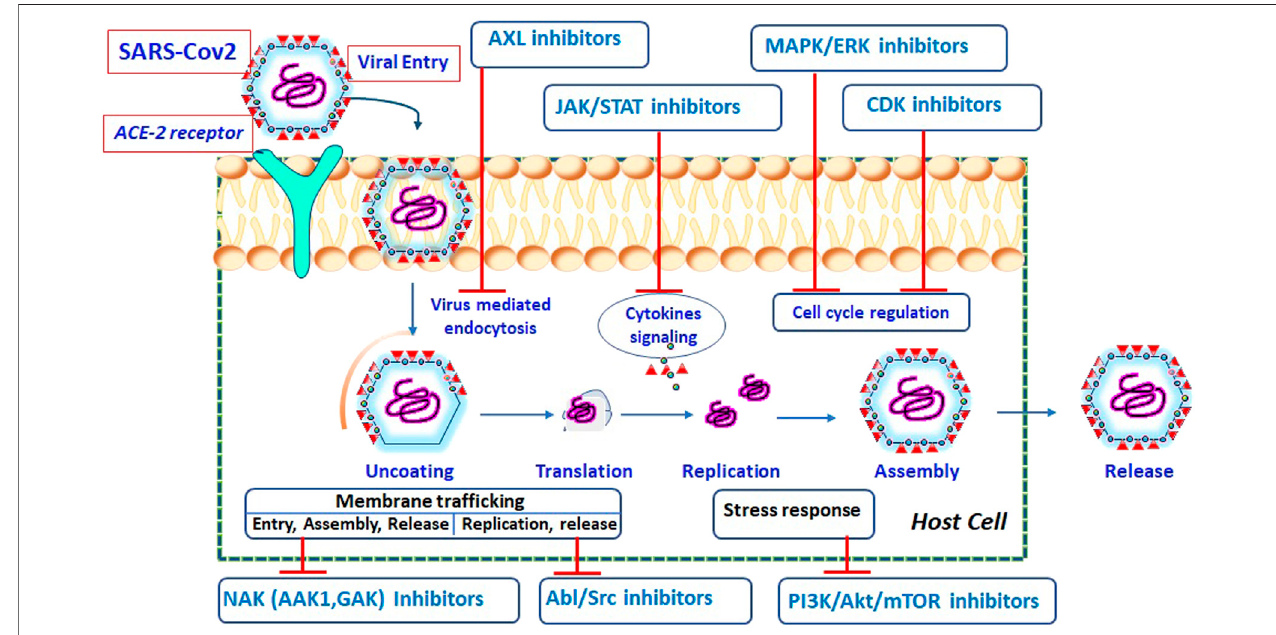
FIGURE 1 | Schematic representation of SARS-CoV-2 life cycle at different stages and possible inhibitors acting on speci fi c target (Pillaiyar and Laufer, 2021).